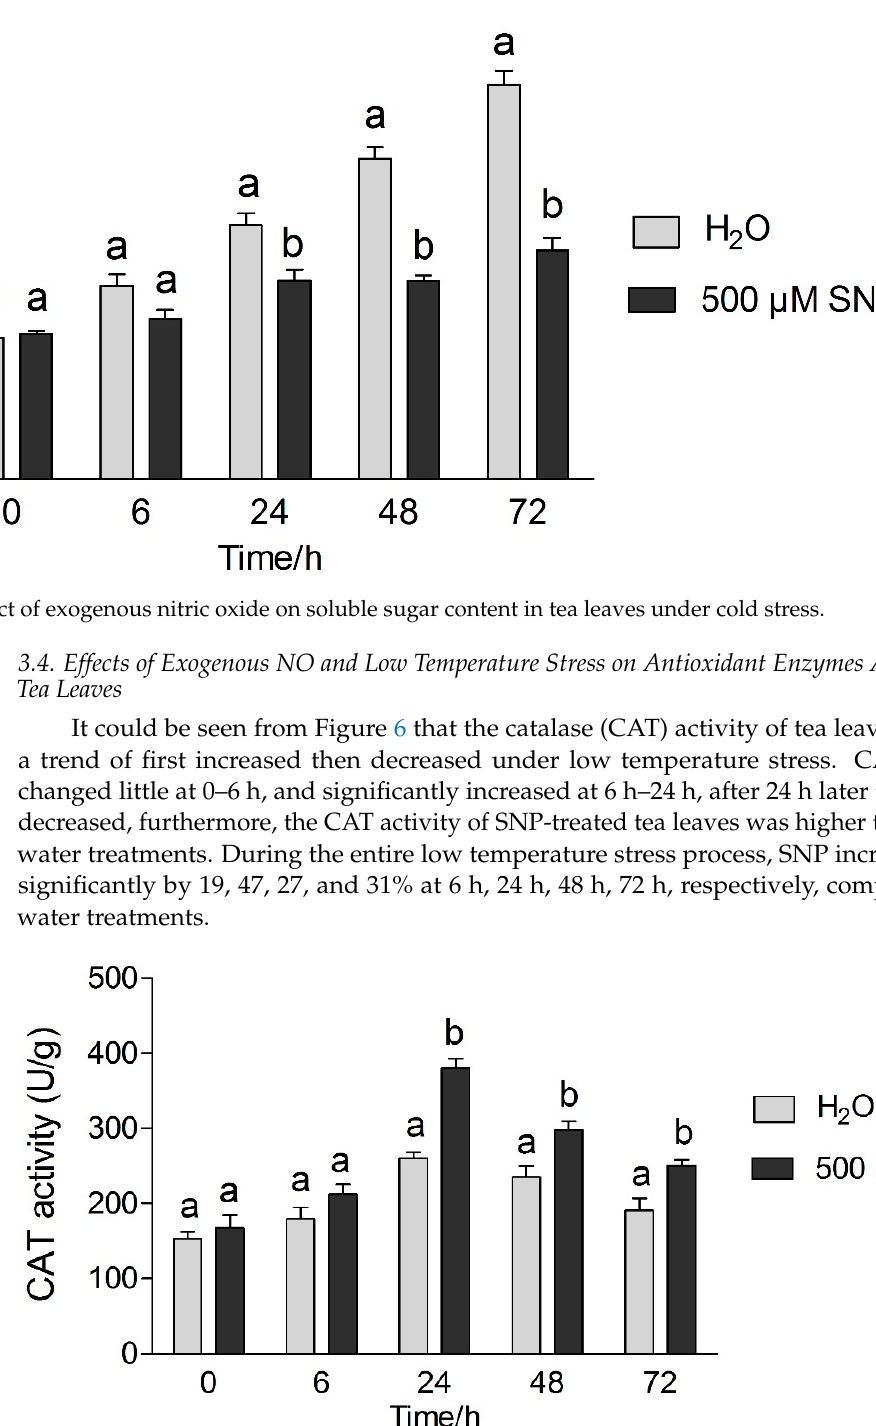
Figure 5. Effect of exogenous nitric oxide on soluble sugar content in tea leaves under cold stress.